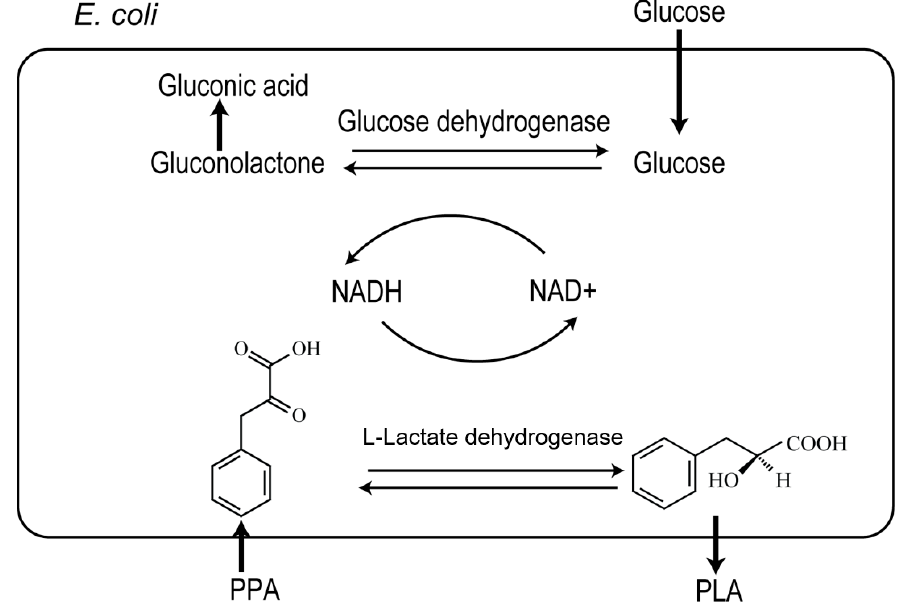
Figure 1. Scheme for the production of L -PLA from PPA by the NADH-dependent L -LDH and GDH coupling system. NADH represents the reduced form of nicotinamide adenine dinucleotide.